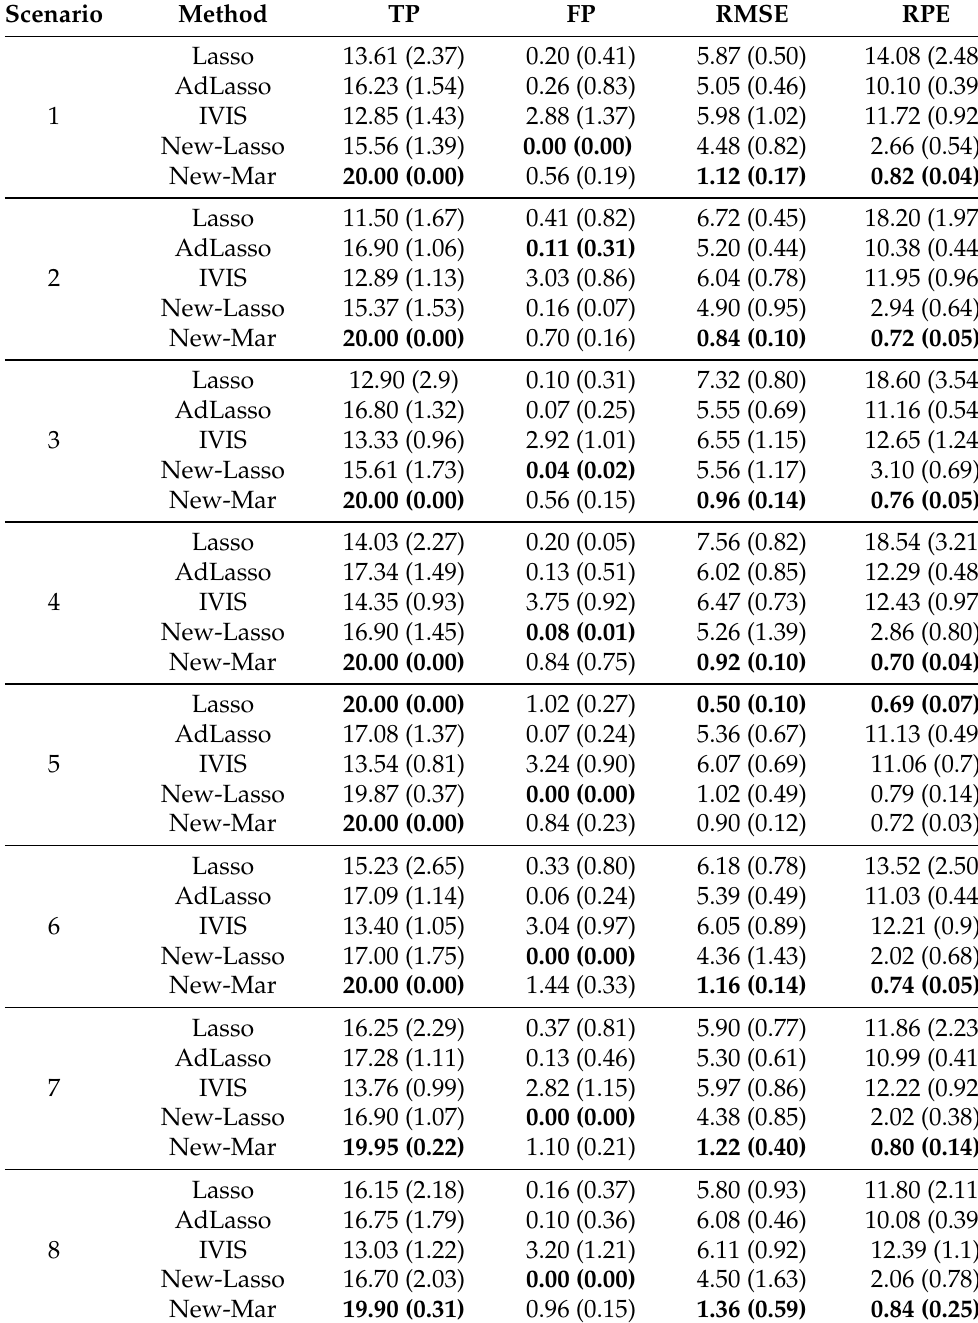
Table A1. Simulation results for N = 200, p = 500, q = 20, and ρ = 0.8. Each cell shows the mean (sd). The bold represents the best